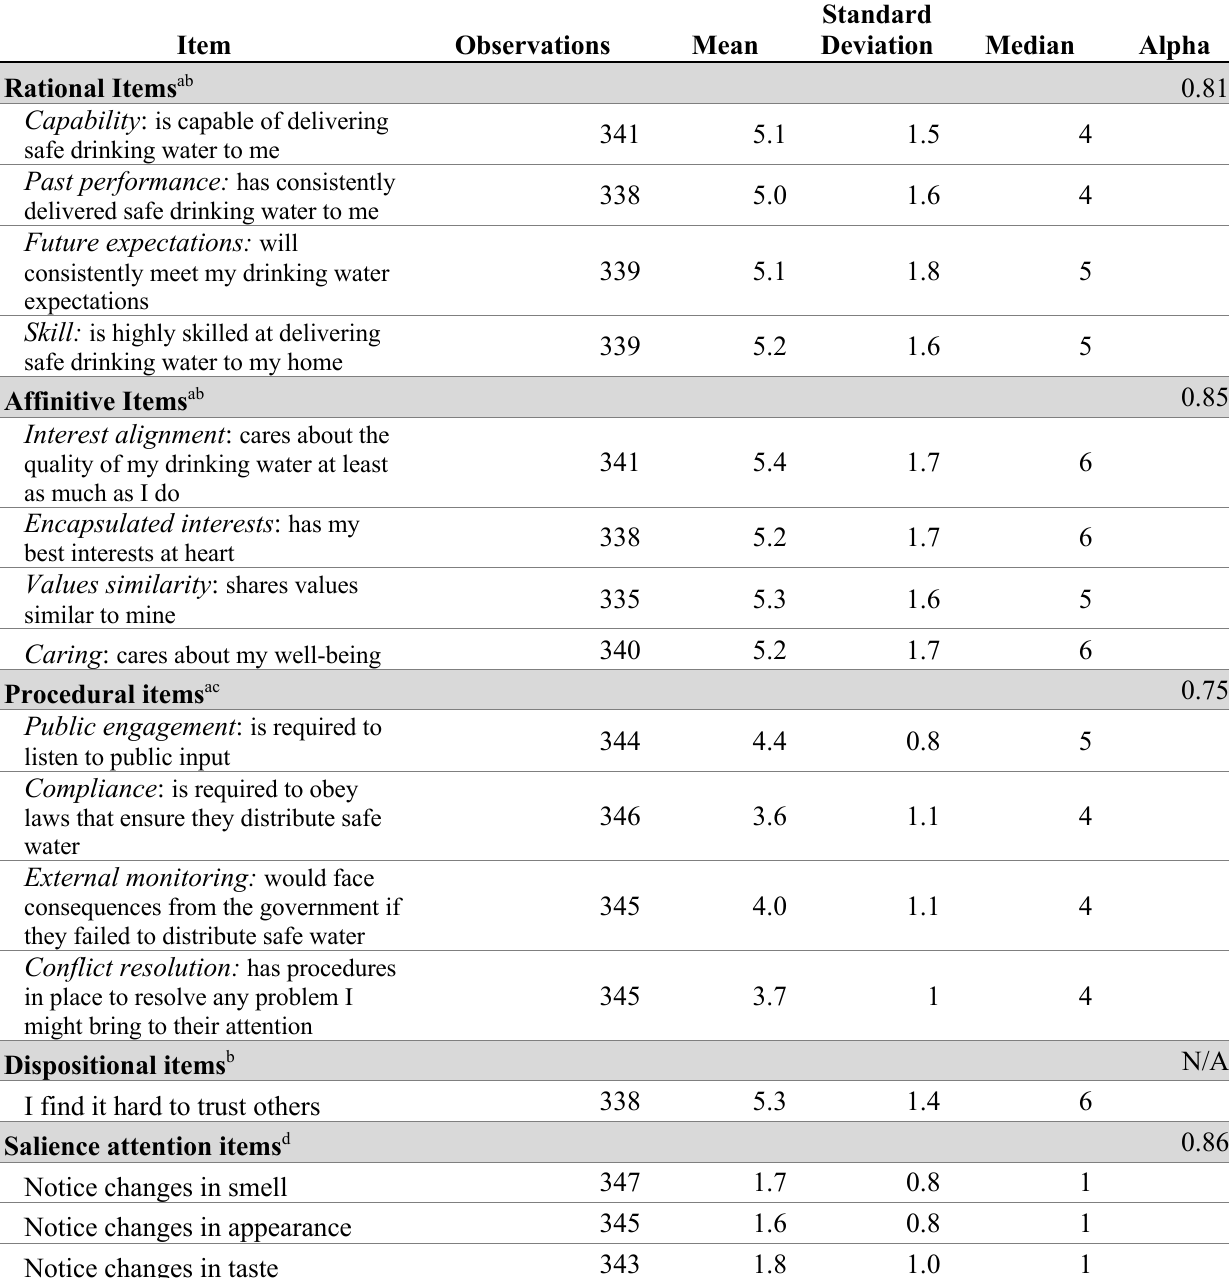
Table A1.1 : Indicators used to create composite